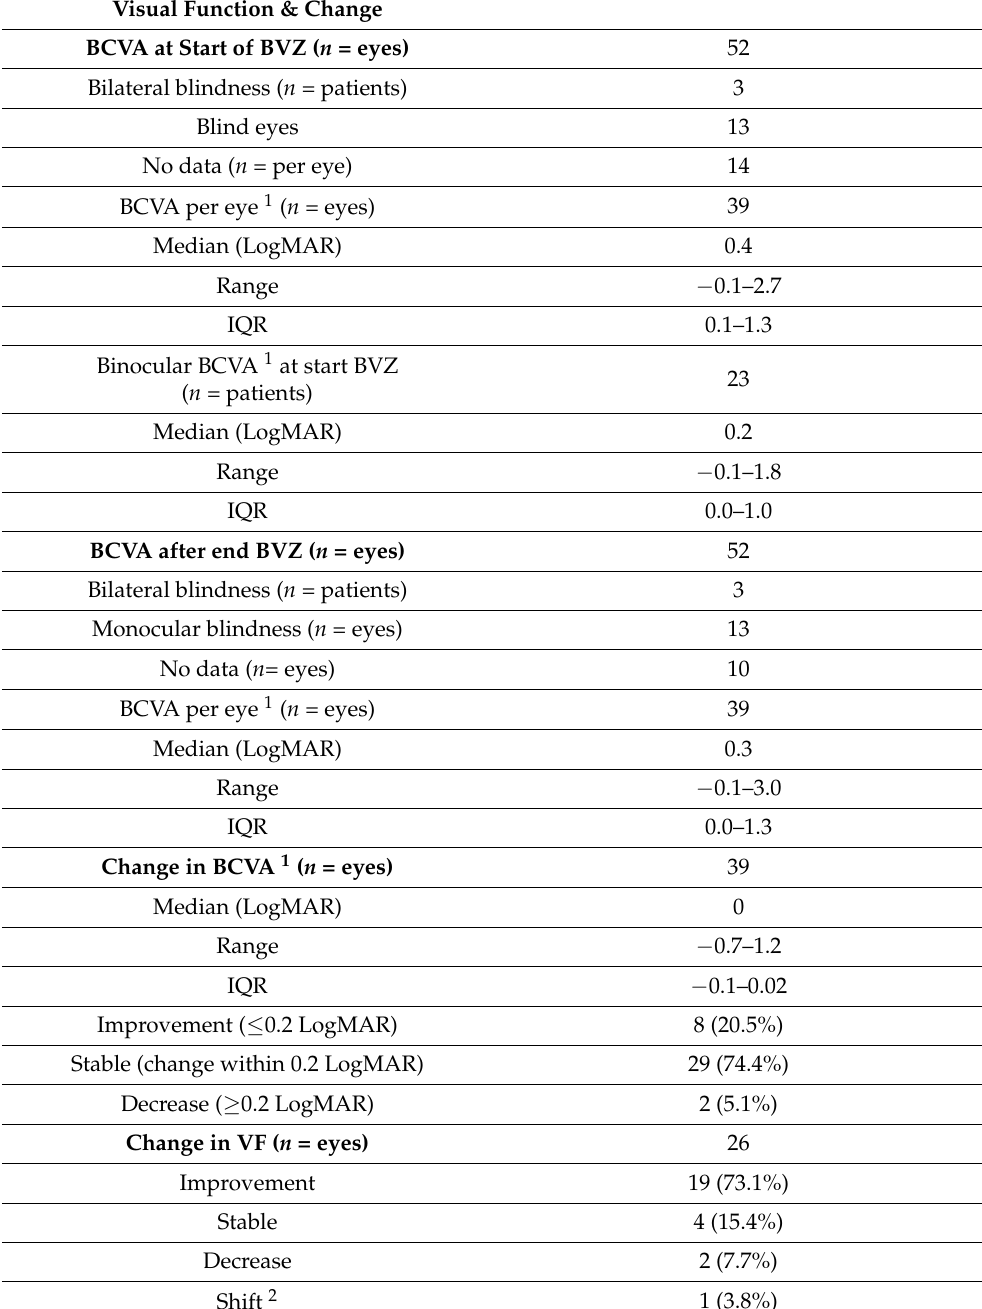
Table 2. Baseline data on visual acuity and visual field and change in function after treatment with BVZ. Visual Function & Change BCVA at Start of BVZ ( n = eyes) 52 Bilateral blindness ( n = patients) 3 Blind